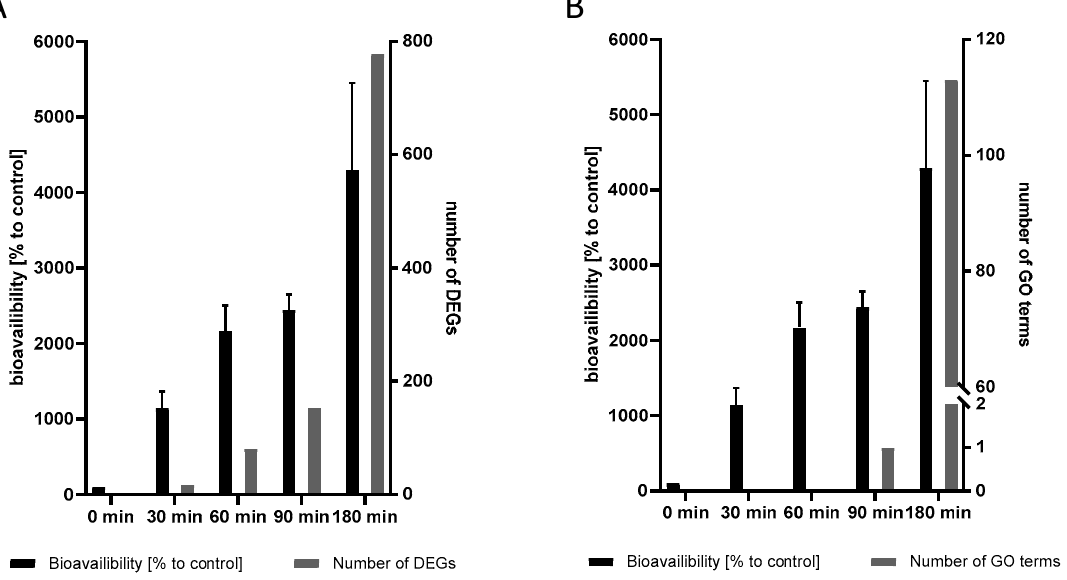
Figure 6. Time course of Mn bioavailability and ( A ) number of DEGs and ( B ) number of GO terms. Bioavailability data are shown as means ± SEM of four independent experiments.